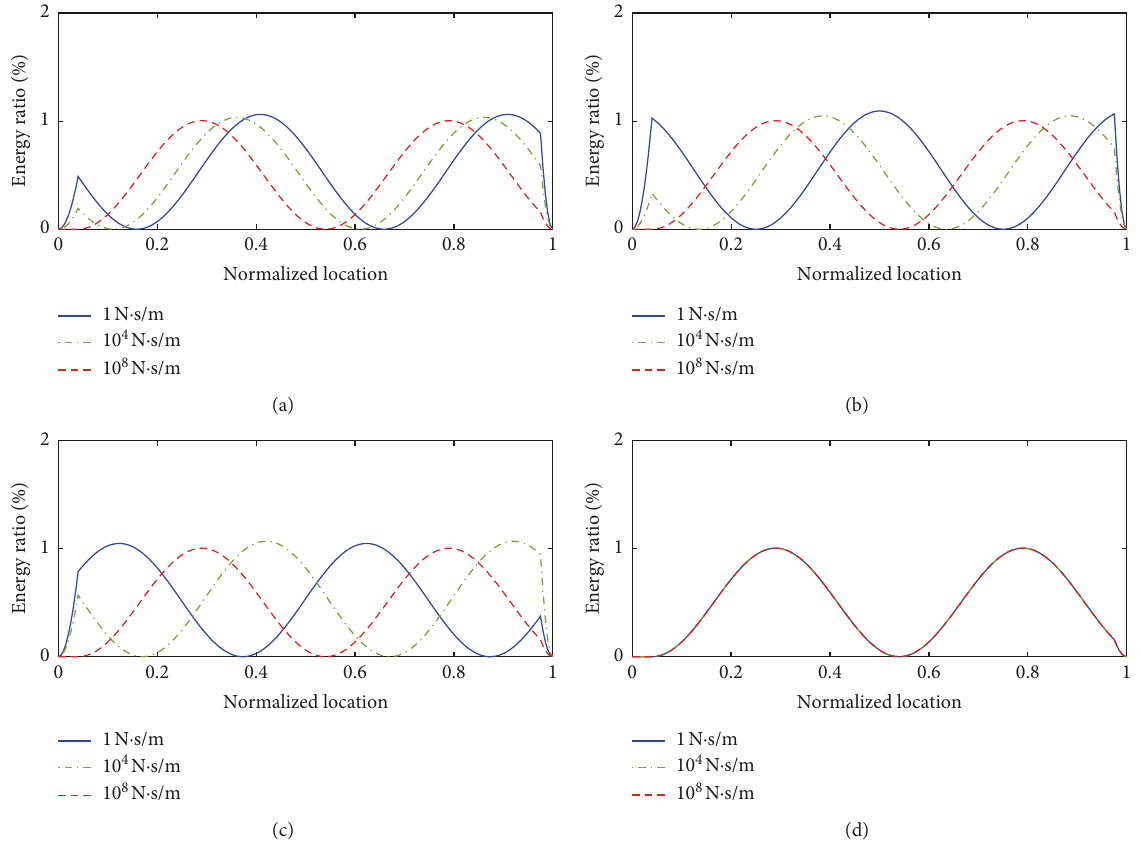
Figure 18: Distribution of the cable mechanical energy under the second modal vibration: (a) k | � − 0 . 8; (d) k / | k opt (c) k d d